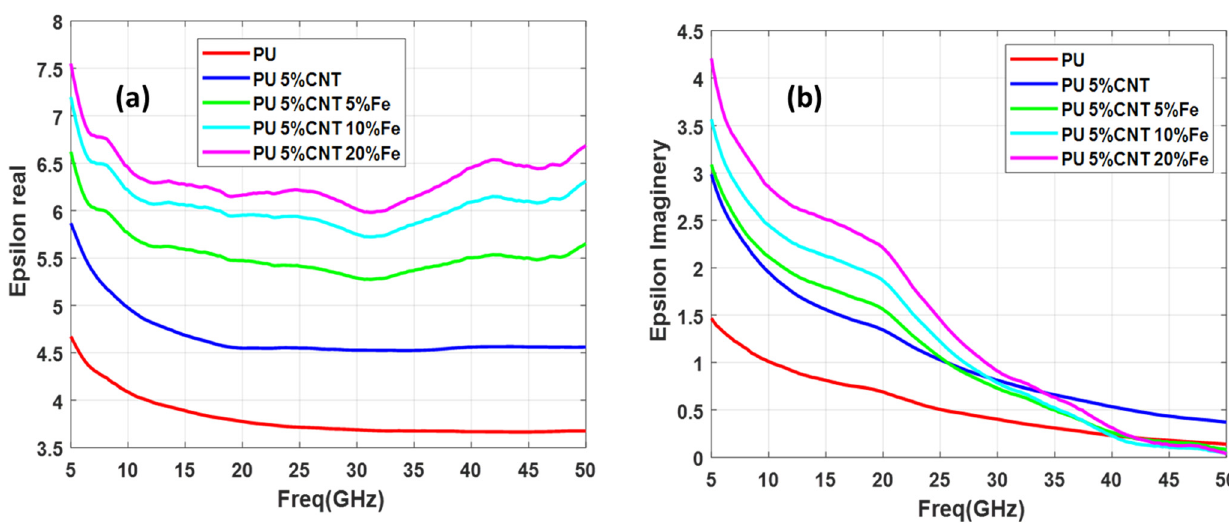
Figure 9. Permittivity of PU + 5%CNT with different concentrations of Fe: ( a ) real part ( b ) imaginary part.